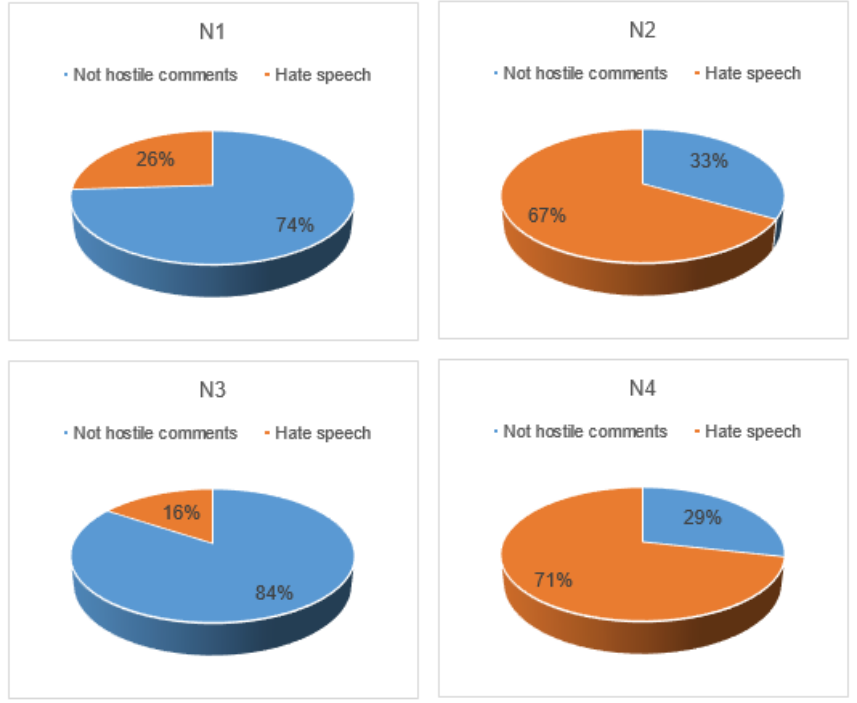
Figure 2. Presence of hate speech in the comments that believed the pseudo-information